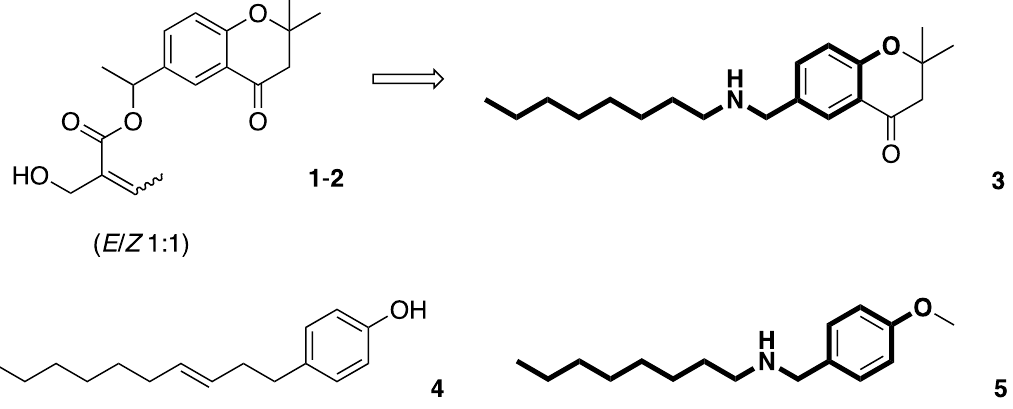
Figure 1. Natural products with activity against Leishmania and their synthetic analogues.